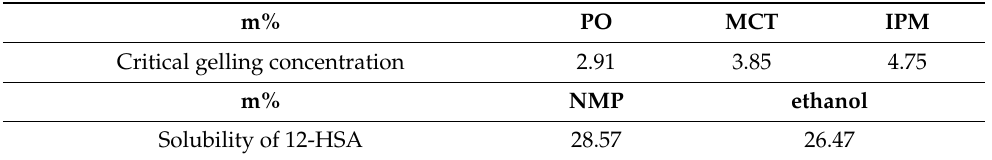
Table 3. The critical gelling concentrations of 12-HSA in PO, MCT, and IPM and the solubility of 12-HSA in NMP and ethanol as the mass fraction composition.